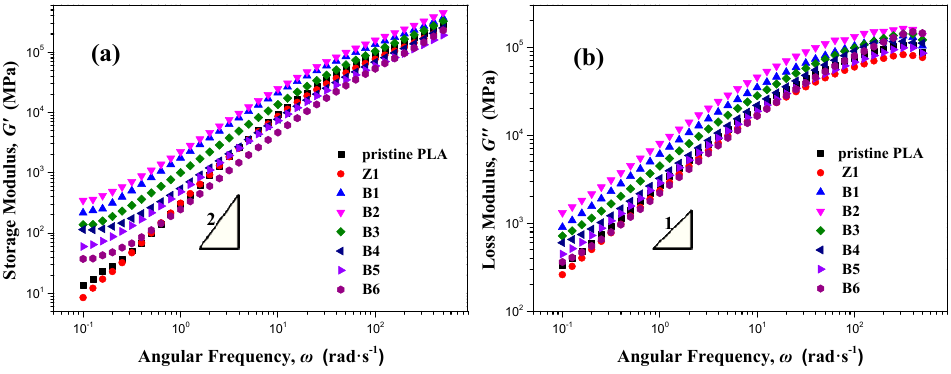
Figure 8. Rheological plots of PLA samples at 170 °C obtained from frequency sweeps: ( a ) storage modulus G ′ and ( b ) loss modulus G ″ as a function of angular frequency.